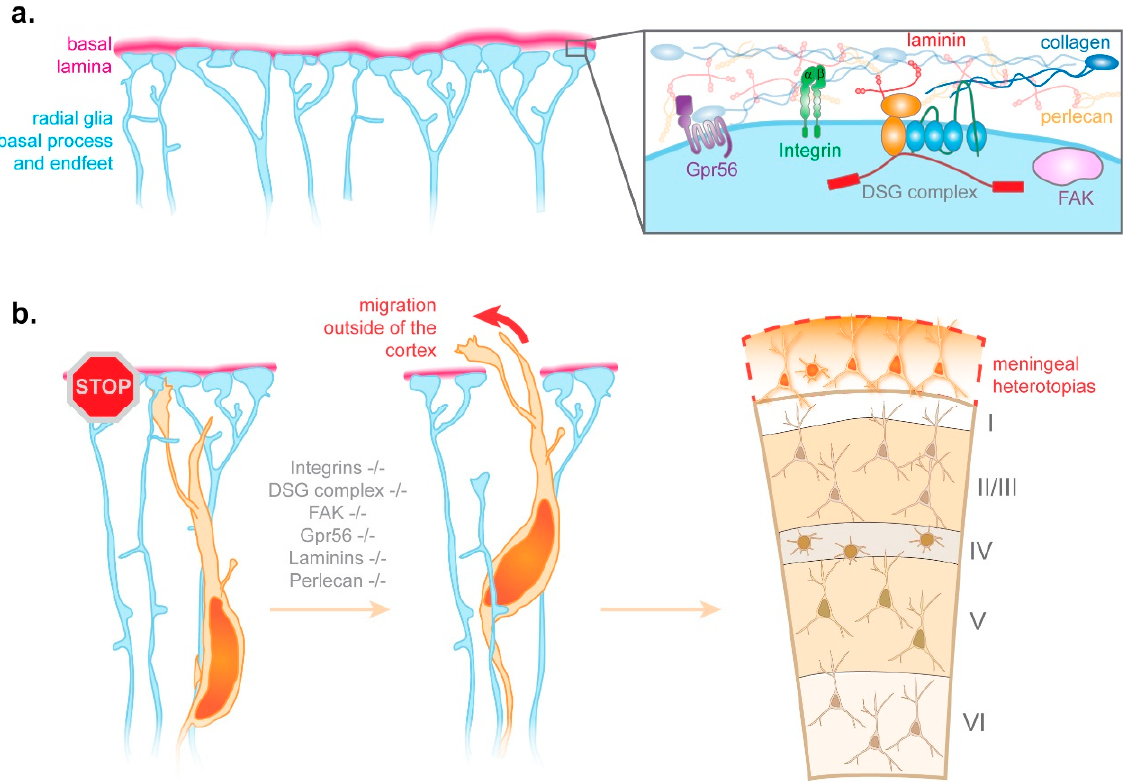
Figure 3. Importance of the radial glia basal endfoot-basal lamina connection for radial migration. ( a ) The basal portion of the radial glial process binds to the extracellular matrix of the basal lamina through transmembrane adhesion receptors located at the level of so-called basal endfeet. Collectively, these endfeet form a barrier demarking the basal boundary of the developing cortex. ( b ) The endfoot barrier restricts neuronal migration to the cortical plate. Compromise of this barrier through malformation of the basal lamina or aberrant endfoot adhesion can lead to neuronal overmigration and ectopic placement in meningeal layers. (DSG complex: Dystrophin-Glycoprotein Complex, FAK: Focal Adhesion Kinase).